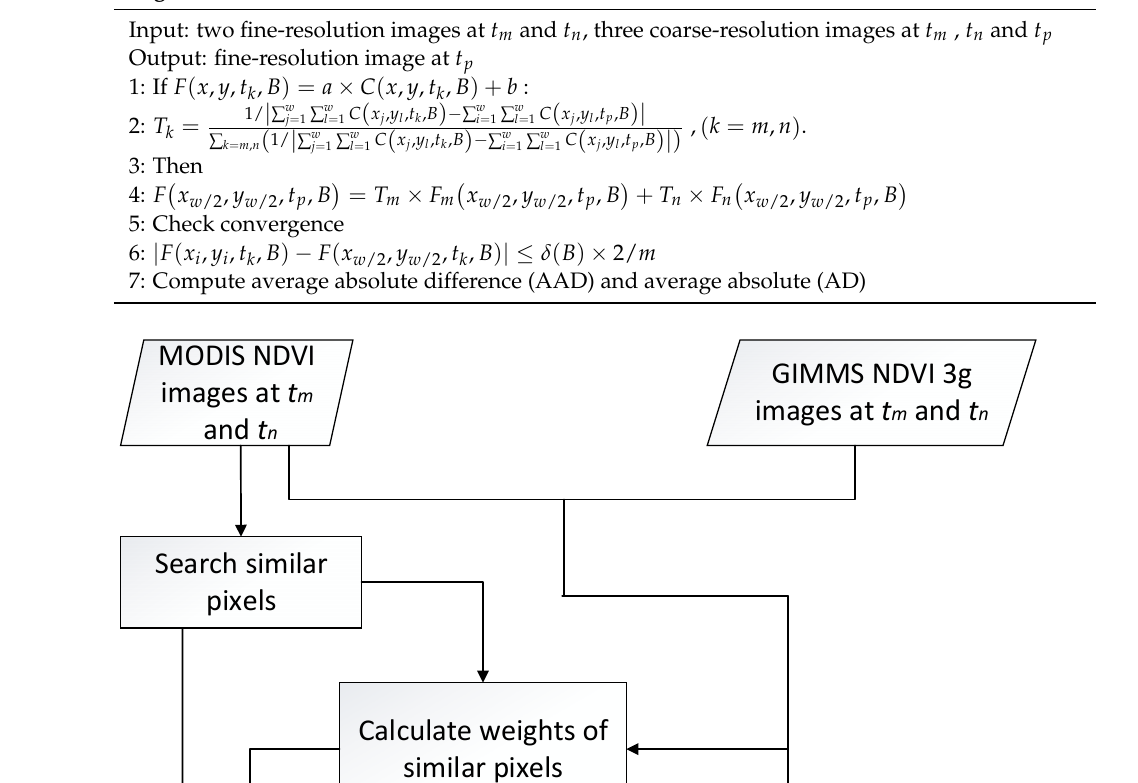
Algorithm 1: Pseudocode of the ESTARFM